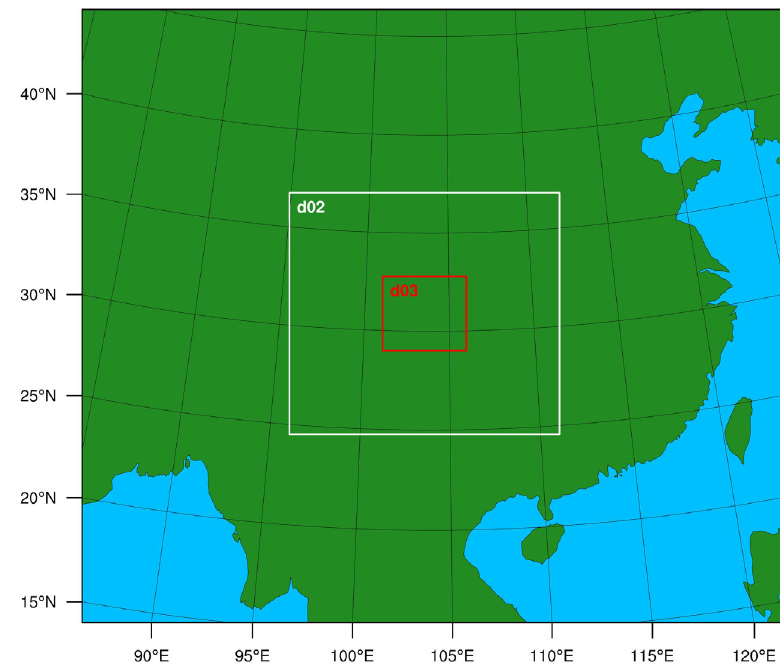
Figure 1. The nested regions in the WRF simulation settings.